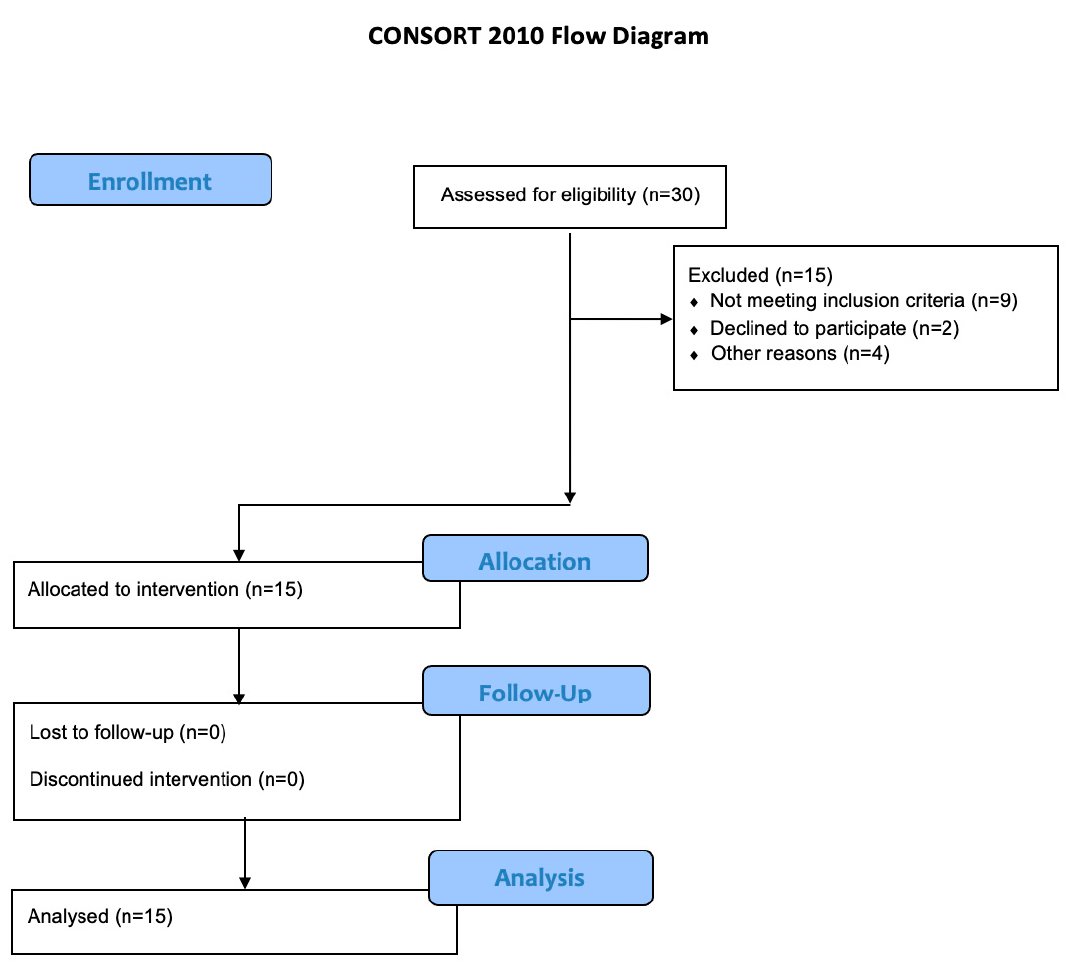
Figure 1. Consort flow diagram.